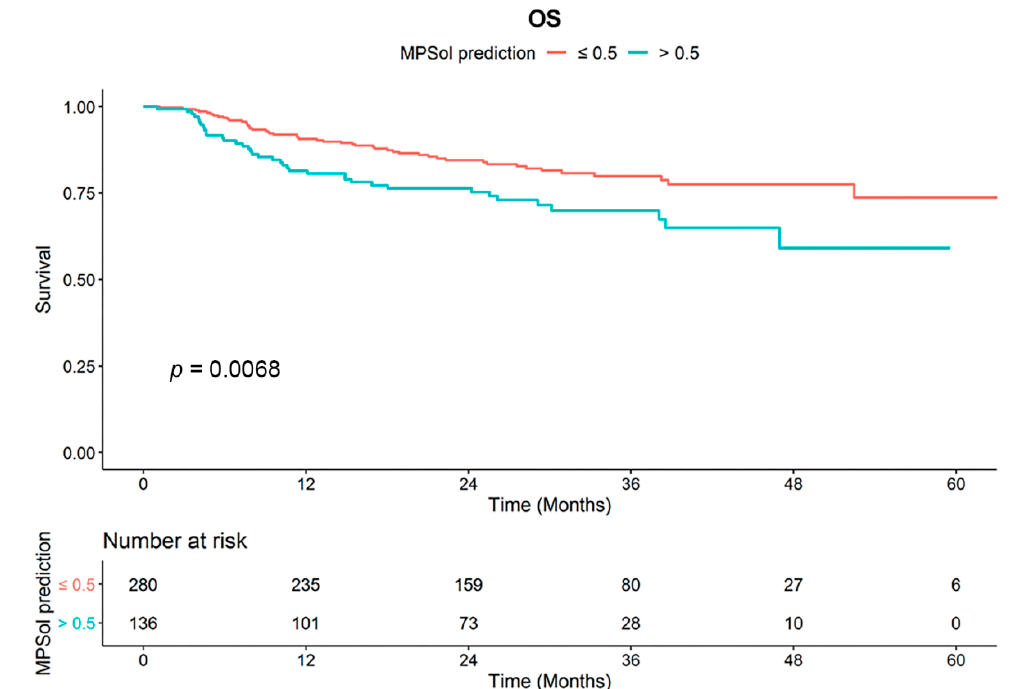
Figure 3. Survival curves for OS according to MPSol probability estimated by MC3DN in the validation set. When the deep learning model was applied to the validation set, a high probability of a high-grade histologic pattern such as the micropapillary and solid pattern (MPSol) was associated with worse overall survival (probability of MPSol > 0.5 vs. < 0.5; 5-year OS rate 59.0% vs. 73.6%).